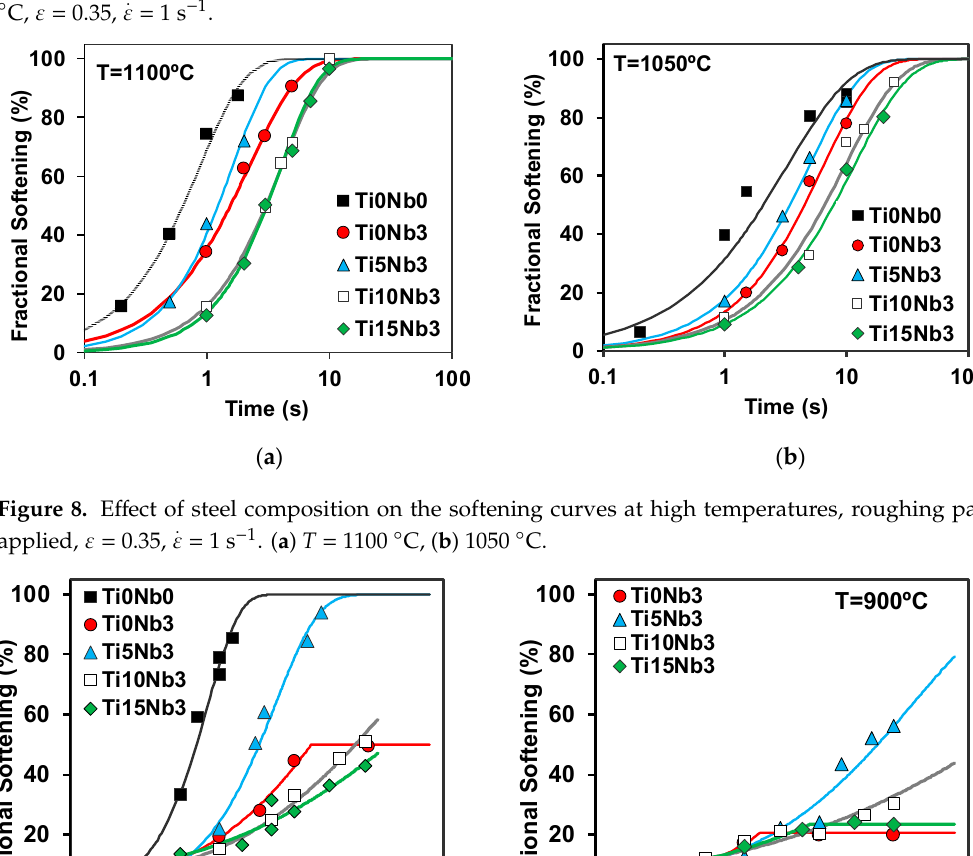
. ε = 1 s − 1 and ( b ) Ti10Nb3 steel, T = 1100